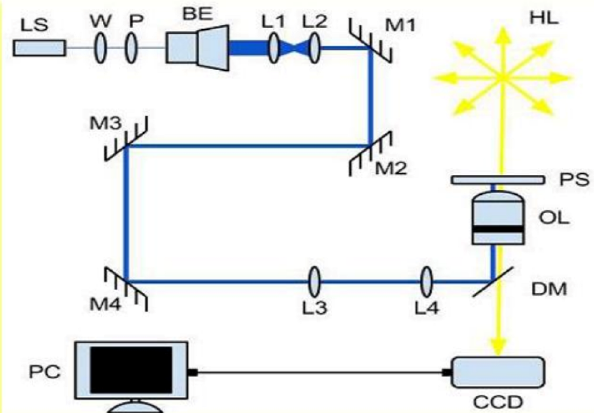
Figure 1. A schematic of the experimental setup of the laser trap. The laser’s wavelength was 1064nm and had a maximum power of 8 watts. The power was controlled by the combination of a half-wave plate (W) and a polarizer (P). A beam expander (BE) along with mirrors (M1, M1, M3, and M4) and lenses (L1, L2, L3, and L4) worked together to align and steer the beam as it passed the dichroic mirror (DM) into the back of the objective lens (OL) to manipulate the cell on the piezo-driven stage (PS). A halogen lamp (HL) illuminated the sample so that consecutive images could be taken by CCD camera and analyzed by computer